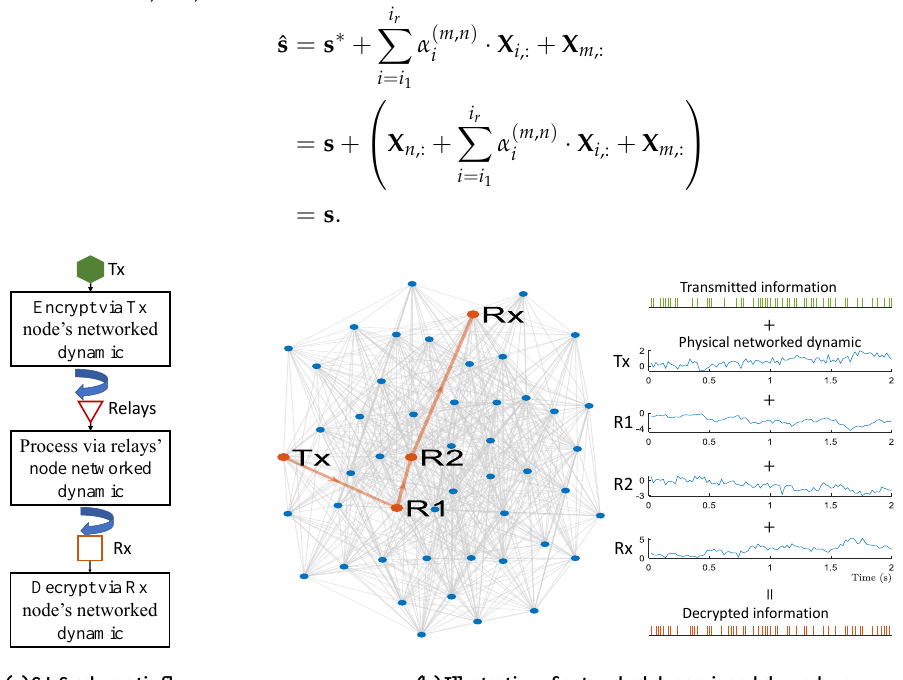
Figure 1. Illustration of graph layer security, where the wireless communications between (Tx,Rx) node pair is secured by the wireless channel-irrelevant physical networked dynamics. The encryption and decoding are leveraging the linear dependency of networked dynamics. ( a ) Shows the GLS schematic flow; ( b ) presents the illustration of the physical networked dynamic and the linear dependency among